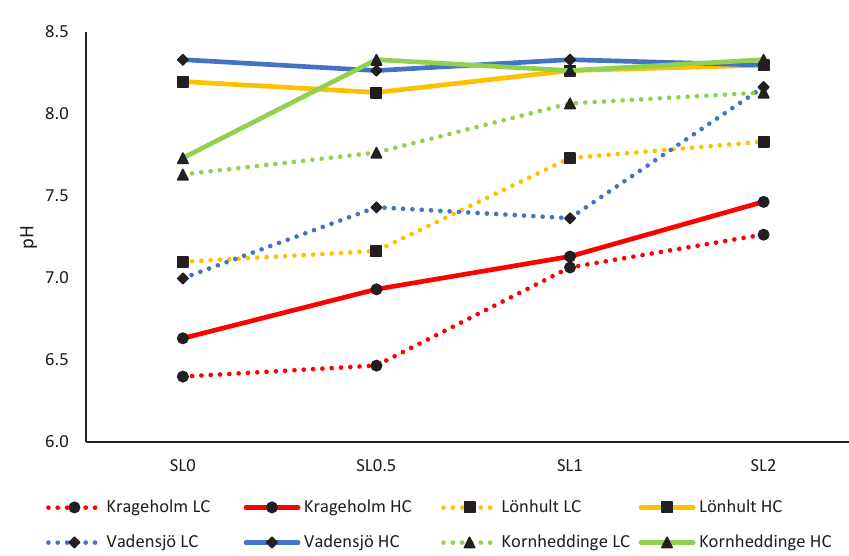
Fig. 3. Interaction plot for mean soil pH measured in 2015, one year after structure liming, in the unlimed control (SL0) and in treatments receiving 4, 8 and 16 t ha -1 structure lime (SL0.5, SL1 and SL2, respectively) at the different experimental trials. HC/LC = high/low